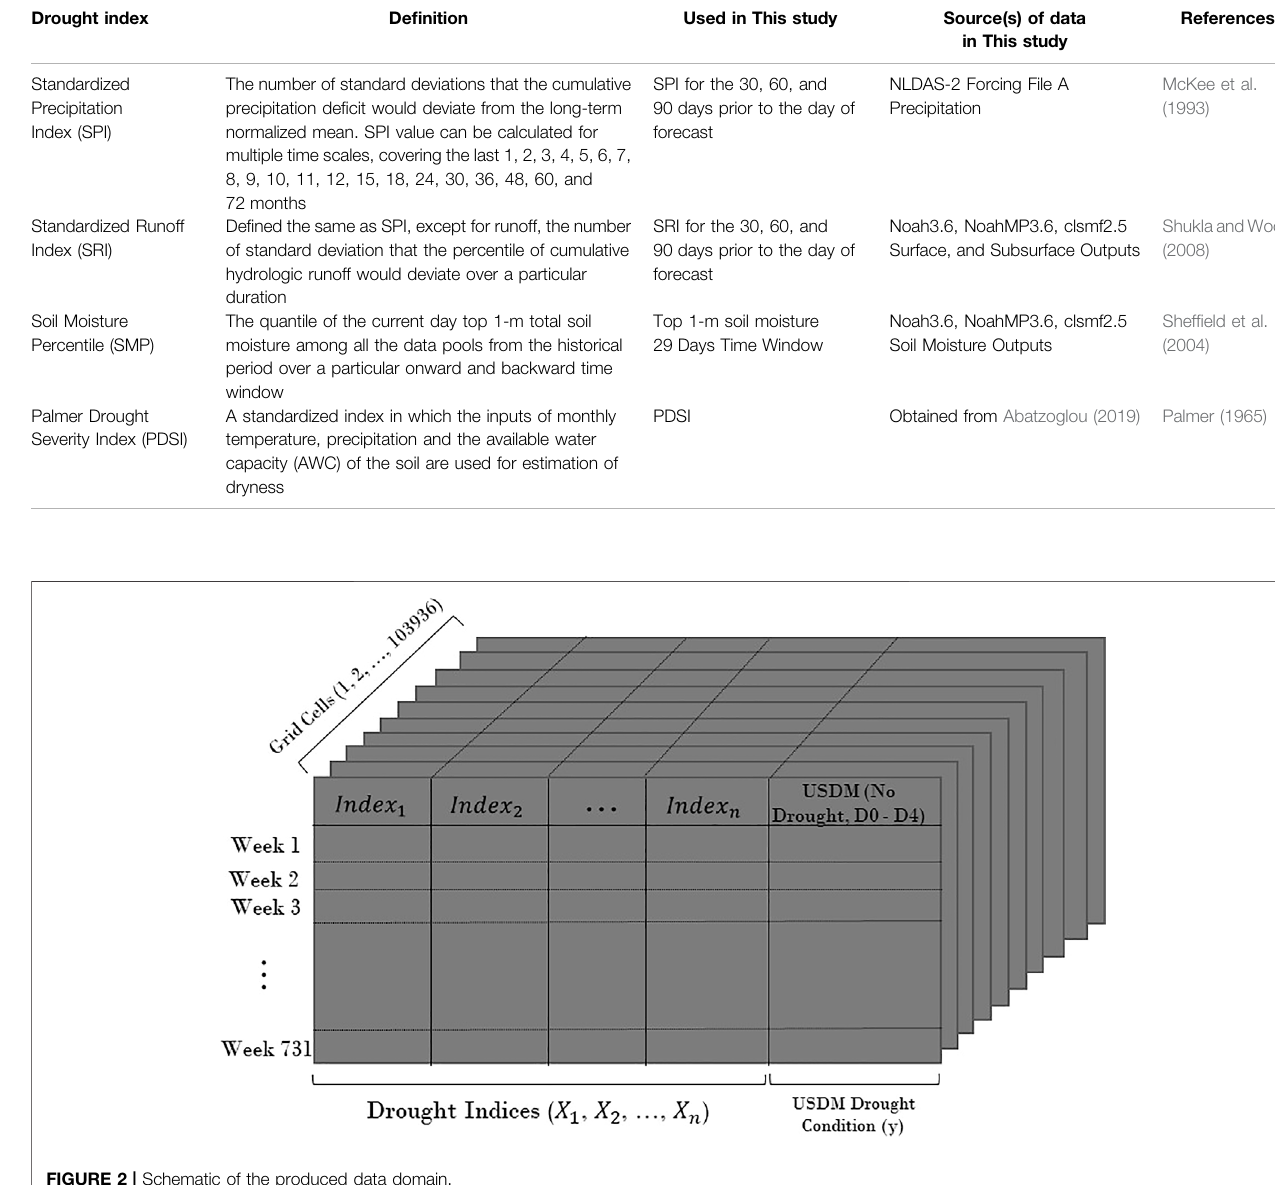
FIGURE 2 | Schematic of the produced data